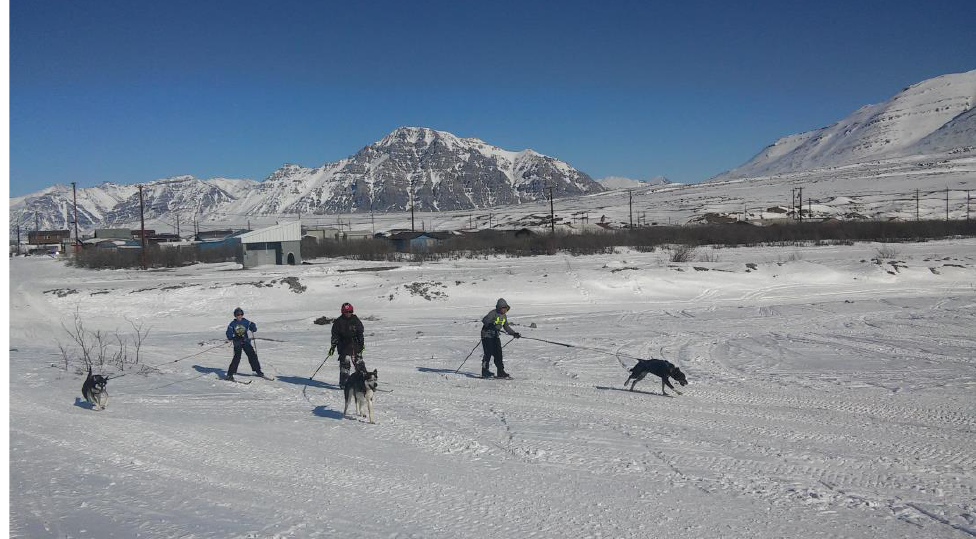
Figure 1. Youth from Anaktuvuk Pass participating in the skijoring program. In this arctic environ- ment, April temperatures can be as low as −20 °F (−30 °C) and the closest town is 250 miles (400 km) south with no road or navigable waterway. Copyright Jacques Philip, 2017.